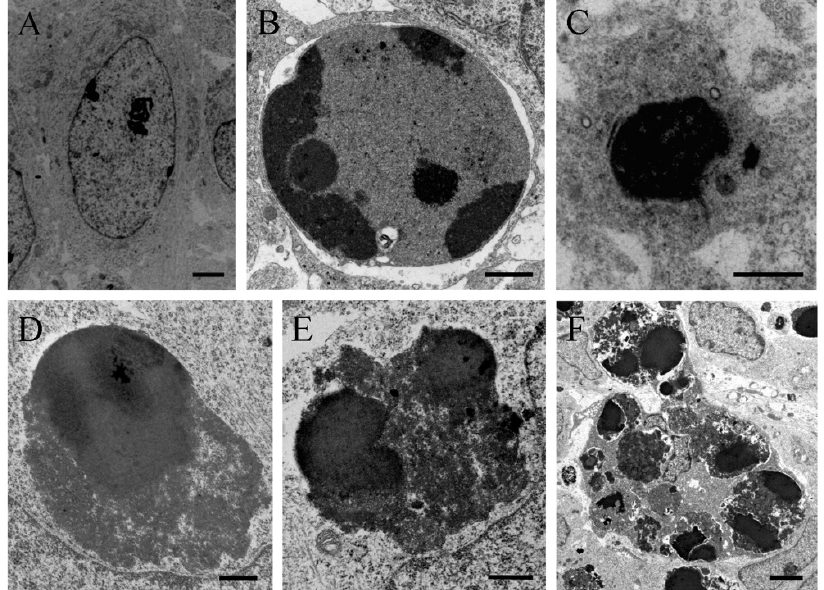
Figure 3. Electron micrograph of a healthy cell ( A ) and apoptotic cellular profile ( B – F ) from the neuroepithelium 10 h following BrdU treatment (100 µg/g). ( C ) Ultrastructural morphology of an apoptotic cell. The masses of compact chromatin display a high electron density and a homogeneous texture. They are associated with an intact nuclear envelope. ( D – F ) Typical electron-dense apoptotic bodies. ( D – E ) Examples of apoptotic bodies releasing their contents into the cytoplasm. Copyright © 2021, Wiley. Adapted with permission from Rodríguez-Vázquez, L.; Martí, J. (2000). Administration of 5-bromo-2 ′ deoxyuridine interferes with neuroblast proliferation and promotes apoptotic cell death in the rat cerebellar neuroepithelium. J. Comp. Neurol. 2021, 529 , 1081–1096. Scale bar: 2 µm ( A ), 1 µm ( B ), 2.5 µm ( C ), 1 µm ( D ), 0.5 µm ( E ), 2 µm ( F ).